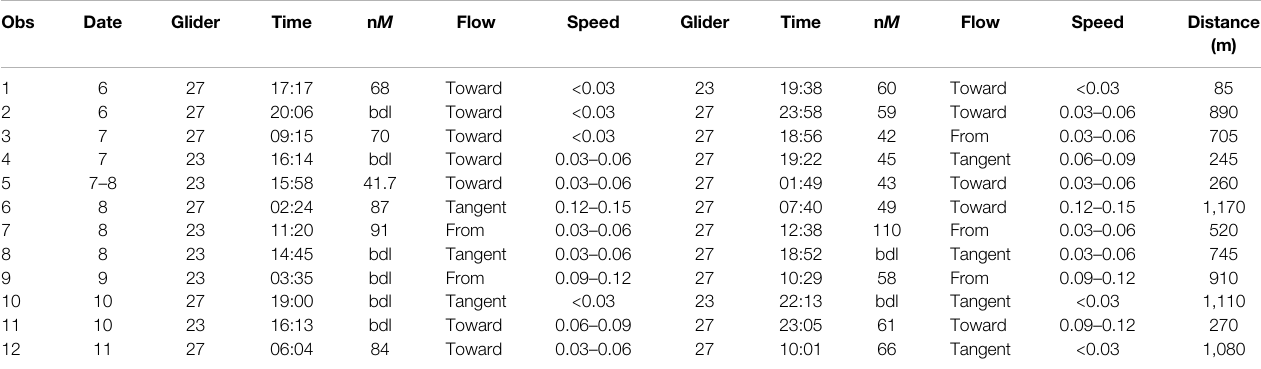
TABLE 1 | Collocated observations with current